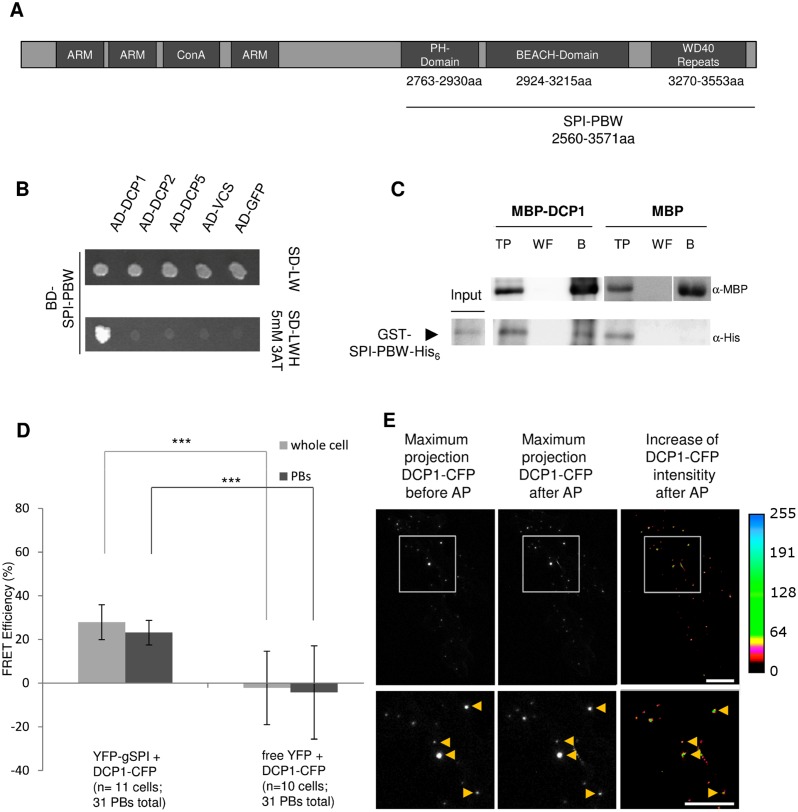
The SPI protein interacts with DCP1.(A) Schematic presentation of the domain organization of the SPI protein: the ARMADILLO repeats (ARM), the Concanavalin A-like lectin domain (ConA), and the C-terminal PBW module (SPI-PBW). (B) Yeast two-hybrid interactions. Upper part: double transformed yeast cells on selective dropout medium lacking leucine (-L) and tryptophan (-W). Bottom part: interaction between SPI-PBW, N-terminally fused to the GAL4 Binding Domain (BD), and DCP1 and other P-body core components fused to the GAL4 Activation Domain (AD), on selective dropout medium lacking leucine (-L), tryptophan (-W), and histidine (-H), supplemented with 5 mM 3-Aminotrizole (3AT). The Green Fluorescent Protein (GFP), N-terminally fused to the GAL4-AD, has been included as negative control. (C) Coprecipitation of SPI-PBW-His6 with DCP1-MBP. Throughputs (TP), wash fractions (WF), and resin-bound MBP fusions (B) were detected by α-MBP (upper part) and α-His6 (lower part) antibody staining. GST-SPI-PBW-His6 (~110 kDa, arrowhead) coprecipitated with MBP-DCP1 (~ 83 kDa), but not with MBP (~42 kDa). Samples detected on different blots are separated by lines. (D) FRETE (in %) was measured in whole leaf epidermis cells (whole cells) and stationary P-bodies (PBs). YFP was bleached in whole cells (for details see Materials and Methods). Mean FRETE’s for 35Spro:YFP-gSPI and 35Spro:DCP1-CFP (n = 11 cells) or 35Spro:YFP and 35Spro:DCP1-CFP (n = 10 cells) are shown. Error bars represent standard deviations for whole cells, and the standard deviation of the mean for PBs (n = 31 stationary PBs derived from whole cell samples). Two-tailed student’s t test was performed to compare FRETE between 35Spro:YFP-gSPI/35Spro:DCP1-CFP and 35Spro:YFP/35Spro:DCP1-CFP for each group (*** p < 0.001). (E) Representative images of 35Spro:DCP1-CFP in a transiently transfected leaf epidermis cell prior to (left) and after (middle) Acceptor-photobleaching (AP). For a better visualization, the increase of fluorescence intensity of DCP1-CFP after AP is presented in pseudocolors (right), see color scale for comparison. A group of stationary PBs is highlighted by the boxed area and magnified (lower row). Yellow arrowheads in magnifications mark stationary PBs used for FRET quantifications. Scale bars: 30 μm.